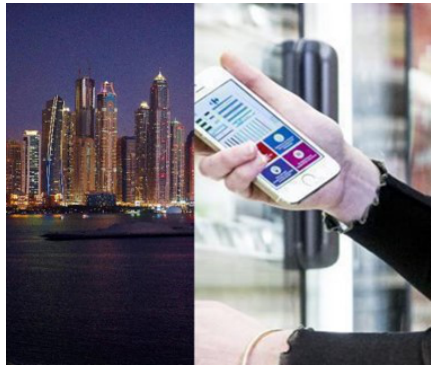
Figure 1. The growing population with increased urbanization results in the need to focus on energy efficiency and sustainability, thereby increasing digitization and rapidly evolving technologies containing